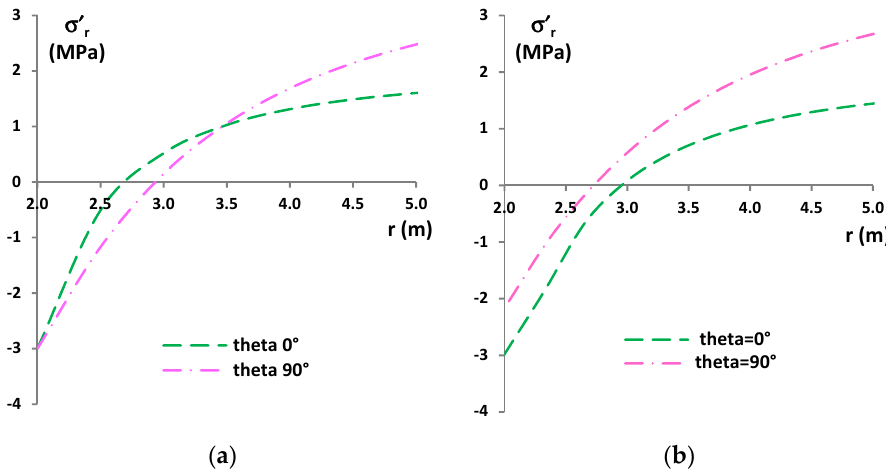
Figure 11. Undrained condition simulated with FLAC in Case 3A. Trend of the effective radial stress with radial distance r. ( a ) Δ u = 0; ( b ) Δ u ≠ 0 (pore pressure shown in Figure 8b).